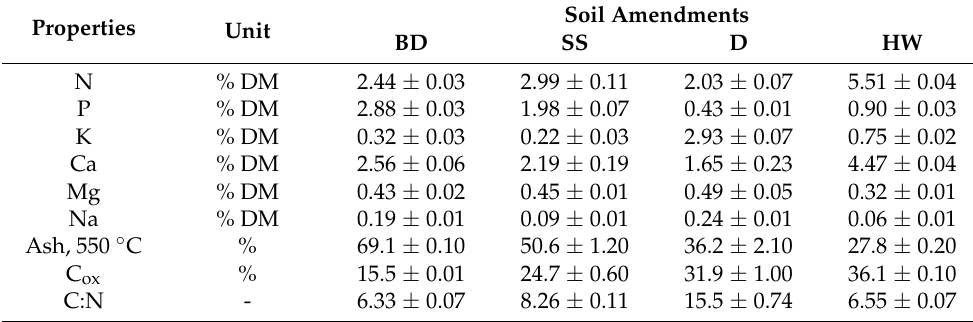
Table 2. Chemical content of the soil amendments.